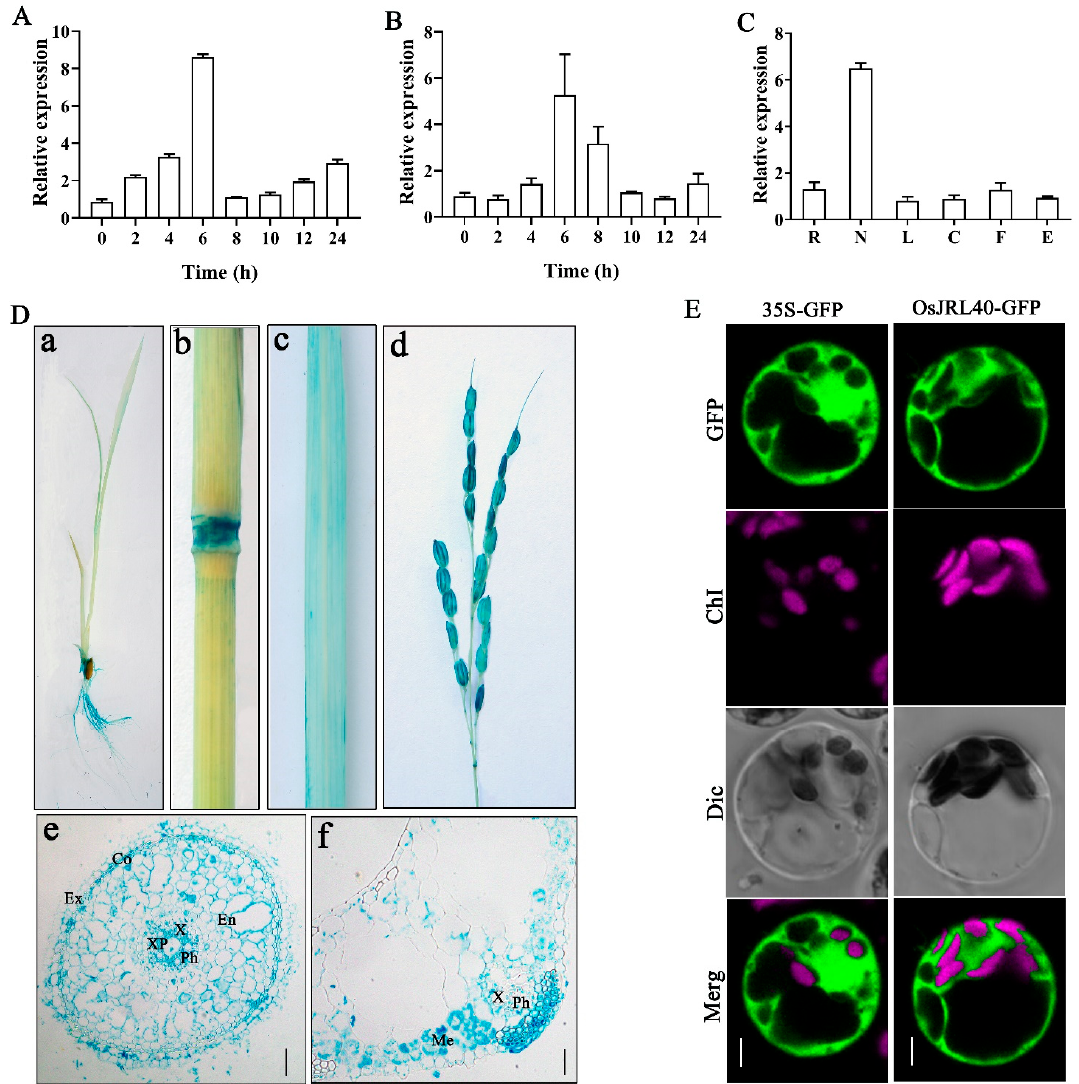
Figure 2. Expression analysis of OsJRL40. ( A ) RT-qPCR analysis of OsJRL40 in rice seedlings treated with 100 mM NaCl. ( B ) RT-qPCR analysis of OsJRL40 in rice seedlings treated with 100 uM ABA. ( C ) Transcript levels of OsJRL40 in different organs of rice plants including the root (R), node (N), leaf (L), culm (C), flower (F), and embryo (E). ( D ) Analysis of GUS staining in transgenic plants expressing the OsJRL40-Pro: GUS construct. GUS staining of seedlings (a), culms and nodes (b), leaves (c), panicles (d), root cross-sections (e), and leaf cross-sections (f) are shown. Scale bar = 20 μ m. ( E ) Subcellular localization analysis of OsJRL40 in Nip rice by confocal fluorescence micros- copy. The red signal represents chlorophyll autofluorescence, and the green fluorescence represents the OsJRL40-GFP fusion protein. Scale bar = 10 μ m.